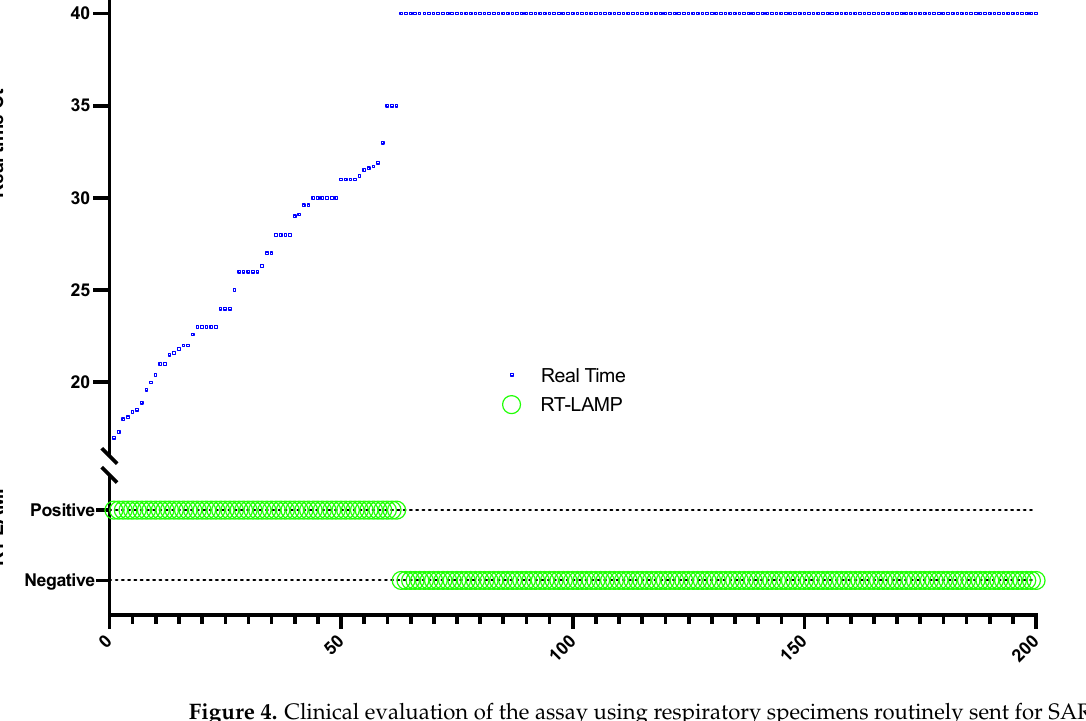
Figure 4. Clinical evaluation of the assay using respiratory specimens routinely sent for SARS-CoV-2 diagnosis (62 positive and 138 negative) by real-time RT-PCR. The positive specimens showed Ct values ranging from 16.8 to 35 in the real-time RT-PCR. The lower part of the Y -axis represents the qualitative results of the RT-LAMP assay (positive/negative) while the upper part represents the corresponding Ct values when tested by real-time RT-PCR.